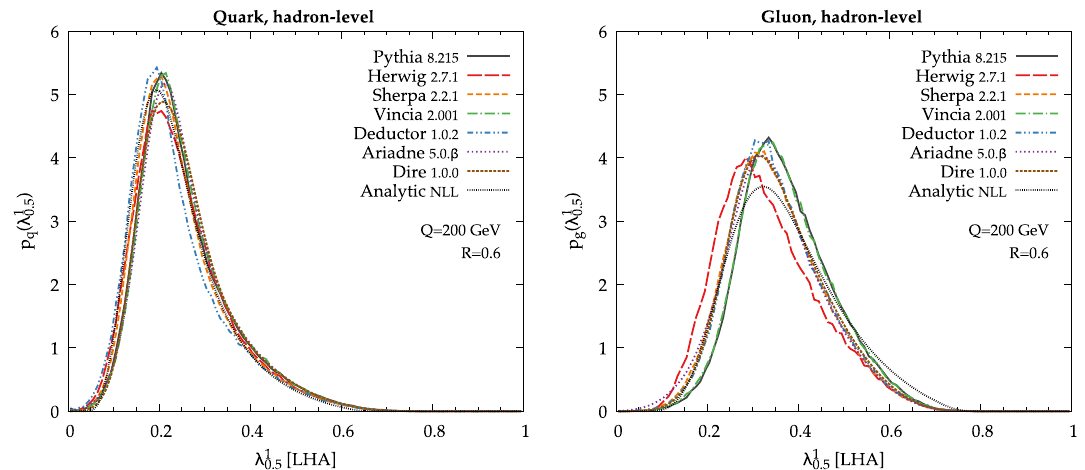
Fig. 5.2 Hadron-level distributions of the LHA variable for the e + e − → u ¯ u (“quark jet”) sample (left) and the e + e − → gg (“gluon jet”) sample (right) predicted by seven parton-shower generators at Q = 200 GeV and jet radius R = 0 . 6 [120]